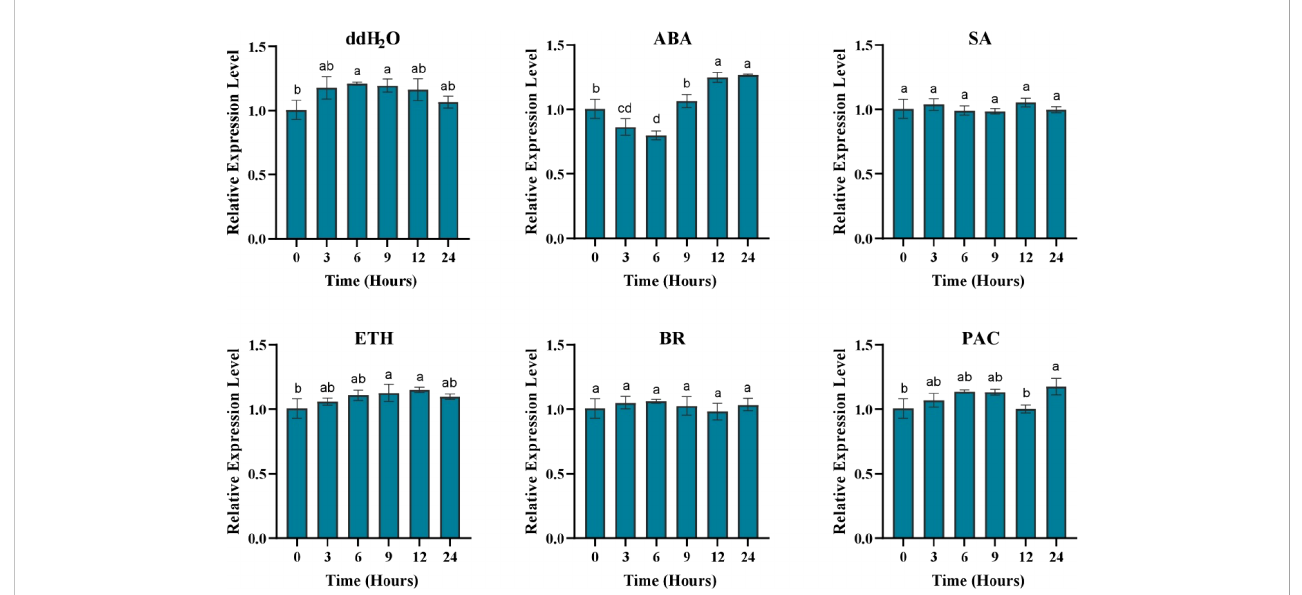
FIGURE 8 Quantitative expression of GUS gene in response to different hormone treatments. The GUS gene showed reduced expression in response to different hormones and ddH 2 O spray at all time points. ABA, abscisic acid; BR, Brassinolide; ETH, ethephon; PAC, paclobutrazol; and SA, salicylic acid. Data were analyzed by analysis of variance (ANOVA, a =0.05